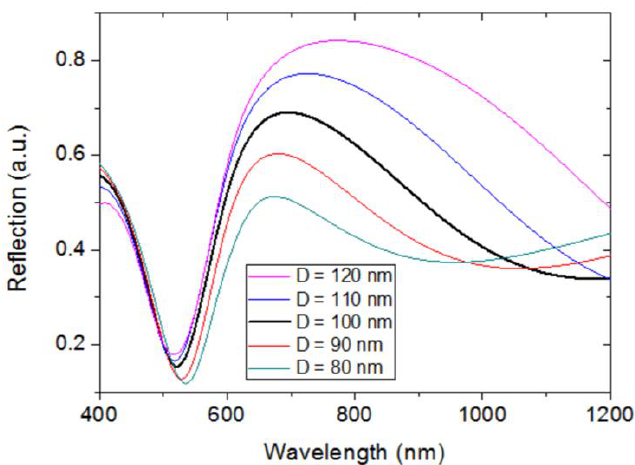
Figure 9. Calculated spectral reflections of the modeled Au NP/SiO 2 /Ti/Mo configuration for different values of the Au NP diameter (D). The array period (P) equals 130 nm.